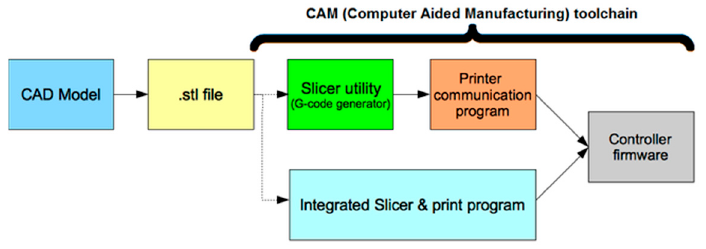
Figure 1. General fused deposition modeling (FDM) process.